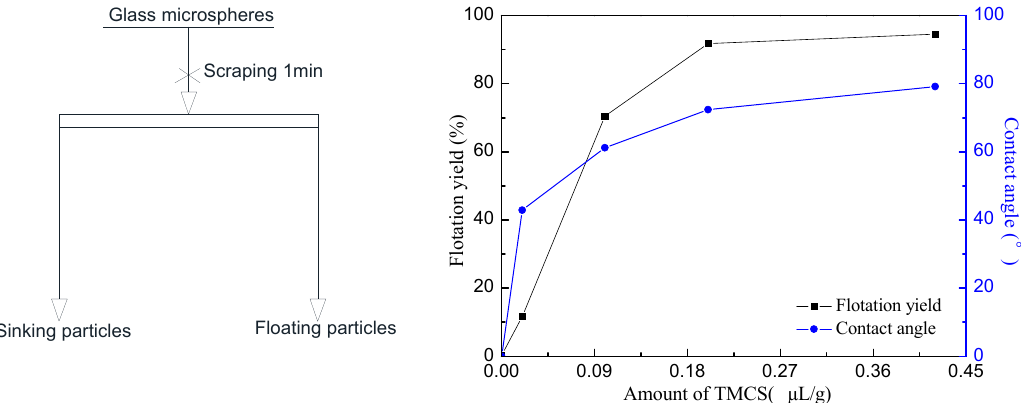
Figure 7. Flotation flow chart of glass microspheres (left) and flotation yield of the − 125 + 74 μ m modified glass microspheres (right).